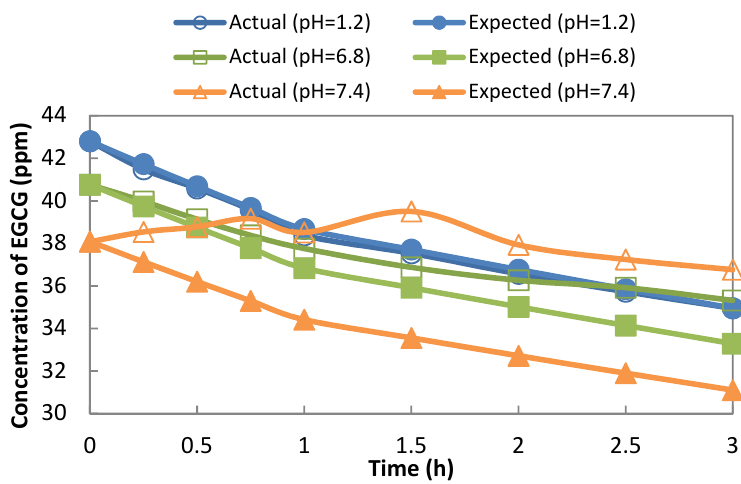
Figure 10. Concentration of free-EGCG against time at pH 1.2, 6.8 and 7.4 at a temperature maintained at 37